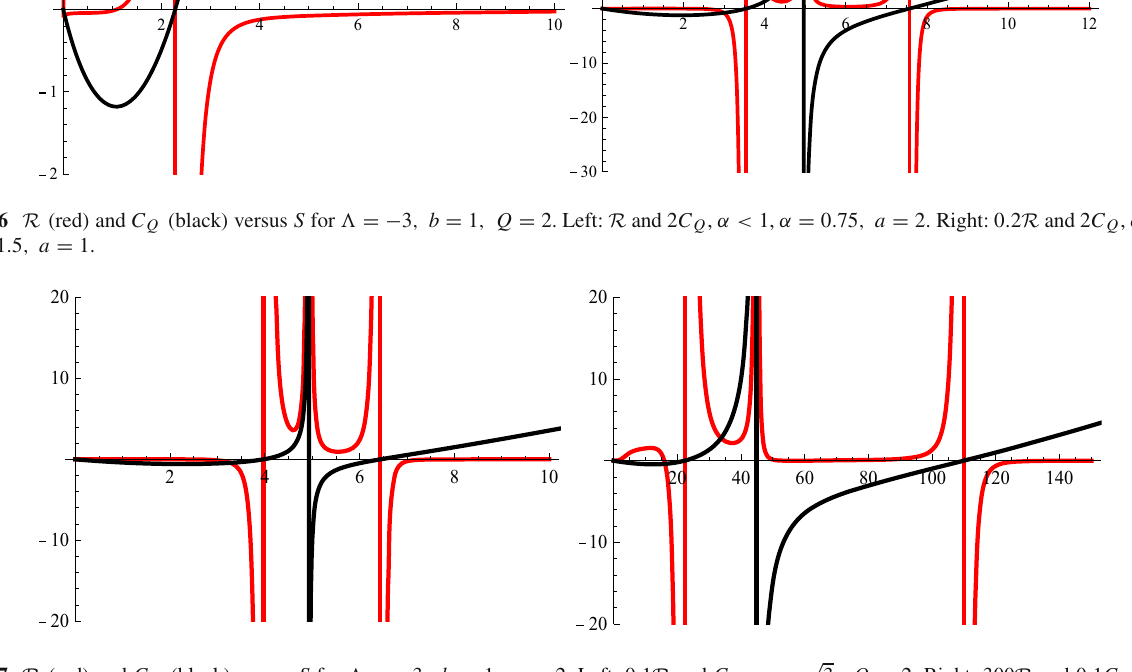
Fig. 7 R ( red ) and C Q ( black ) versus S for (cid:11) = − 3 , b = 1 , a = 2. Left: 0 . 1 R and C Q , α = 1 , Q = 4